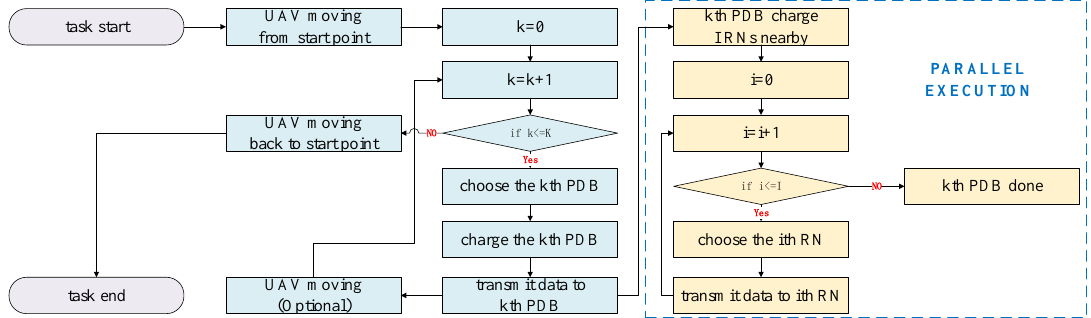
Figure 5. The flow chart of the downlink data transmitting